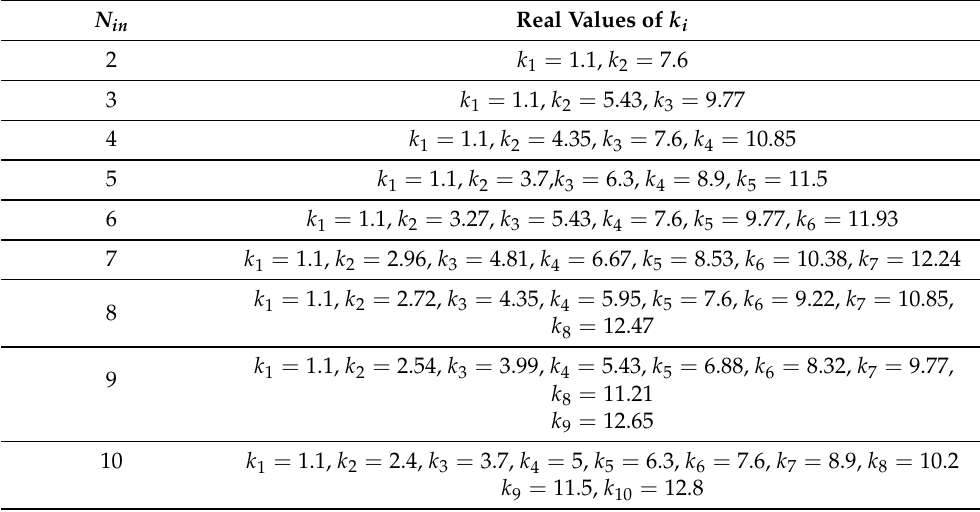
Table 3. Real values of the Weibull parameter k for N in ∈ [ 2..10 ] . N in